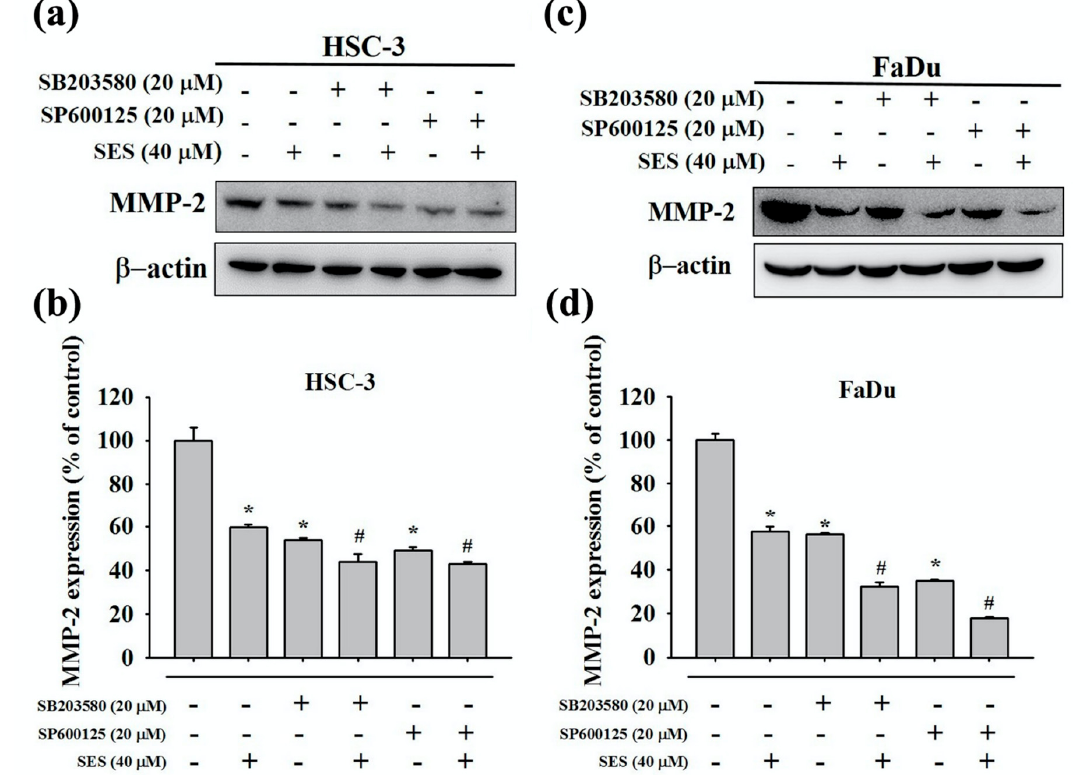
Figure 6. The relationship between MMP-2 and MAPK inhibitors in human oral cancer cells following sesamin treatment. ( a ) HSC-3 and ( c ) FaDu cells were pretreated with SP600125 or SB203580 for 1 h and then incubated in the presence or absence of 40 μ M SES for 24 h. After that, Western blot assays were performed to detect the antibody for MMP-2. ( b ) and ( d ) show the quantitative results of the expression of each protein, after being adjusted to β -actin, in HSC-3 and FaDu cells. The values represent the means ± SD of at least three independent experiments. * p < 0.05, compared with the control group. # p < 0.05, compared with the SES-treated group.